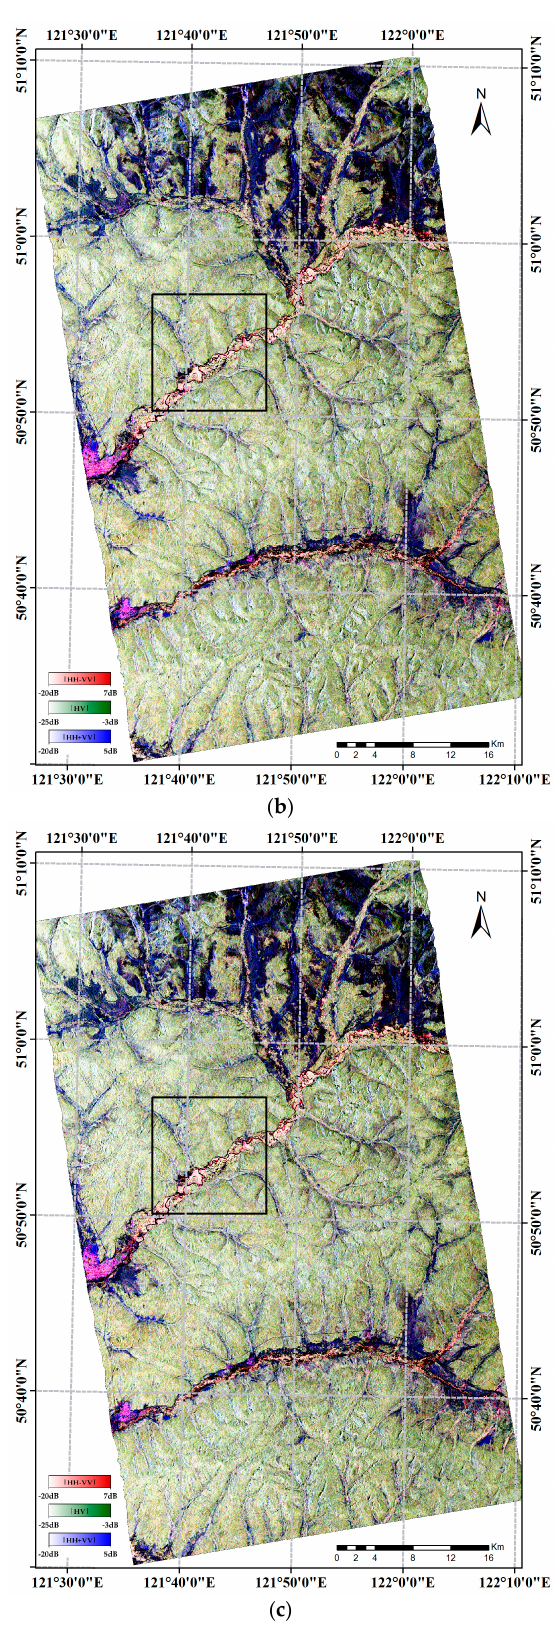
Figure 15. The PolSAR Pauli RGB after each correction step: ( a ) POA correction; ( b ) POA + ESA correction; ( c ) POA + ESA + AVE correction.